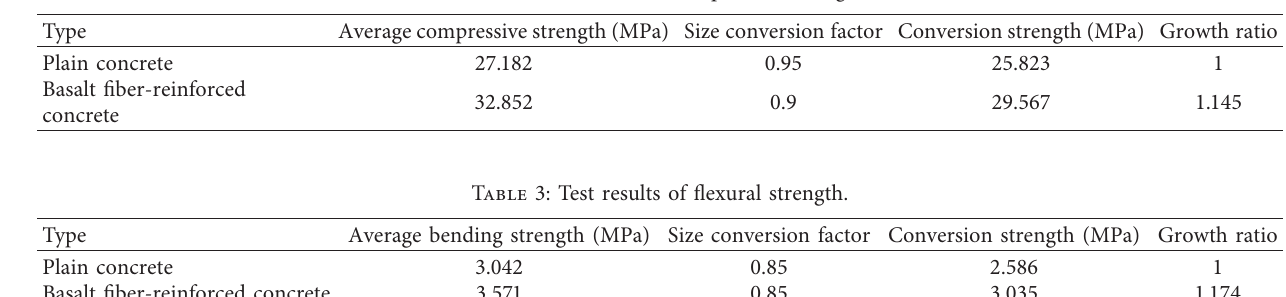
Table 2: Test results of compressive strength.